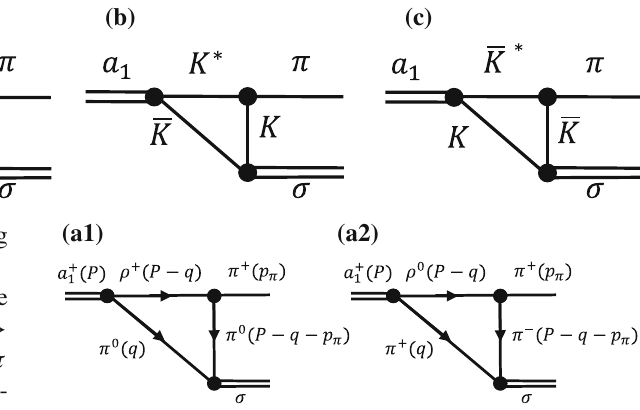
Fig. 2 Detail of diagram (a) of Fig. 1 showing explicitly the ρ + π 0 and ρ 0 π + decays of the a 1 . Particle momenta are shown in